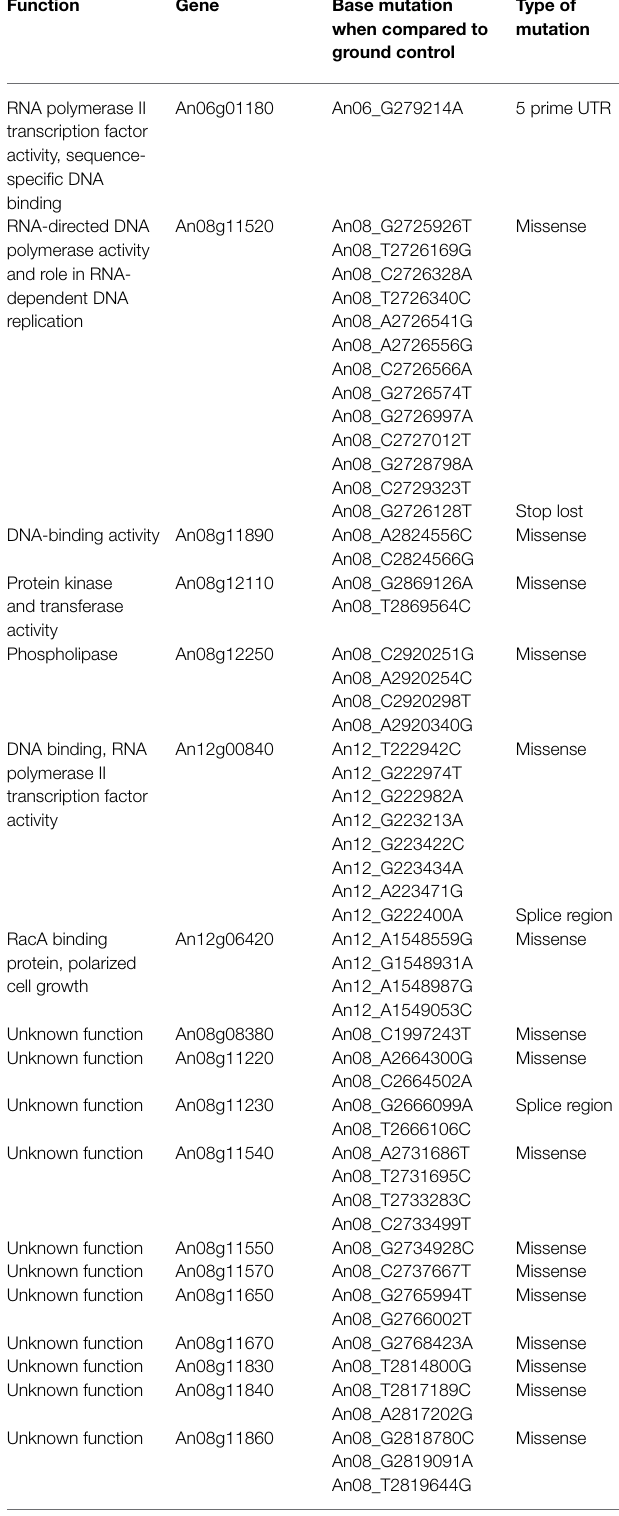
TABLE 2 | Single-nucleotide polymorphisms (SNPs) in ISS-grown JSC- 093350089 when compared to ground control.